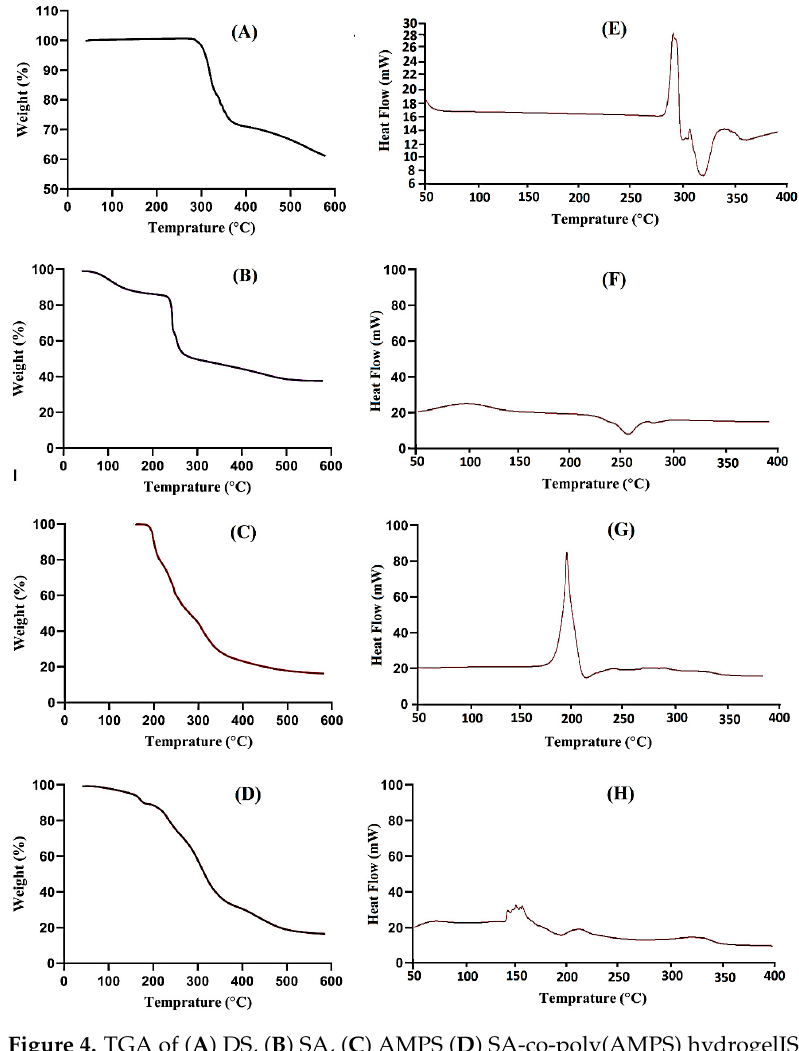
Figure 4. TGA of ( A ) DS, ( B ) SA, ( C ) AMPS ( D ) SA-co-poly(AMPS) hydrogelISC of ( E ) DS, ( F ) SA, Figure 4. TGA of (A) DS, (B) SA, (C) AMPS (D) SA ‐ co ‐ poly(AMPS) hydrogel, DSC of (E) DS, (F) ( G ) AMPS ( H ) SA-co-poly(AMPS) hydrogel. SA, (G) AMPS (H) SA ‐ co ‐ poly(AMPS) hydrogel.